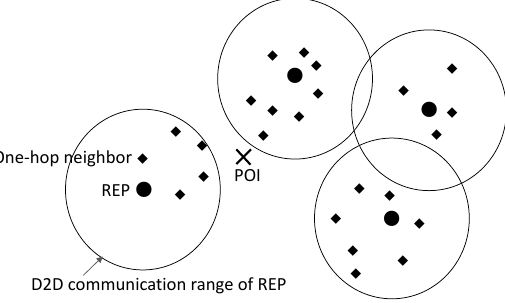
G i = S T . = 𝑆 𝑇 . Figure 7. Example of a case where ∪ i ∈ S R 𝑅